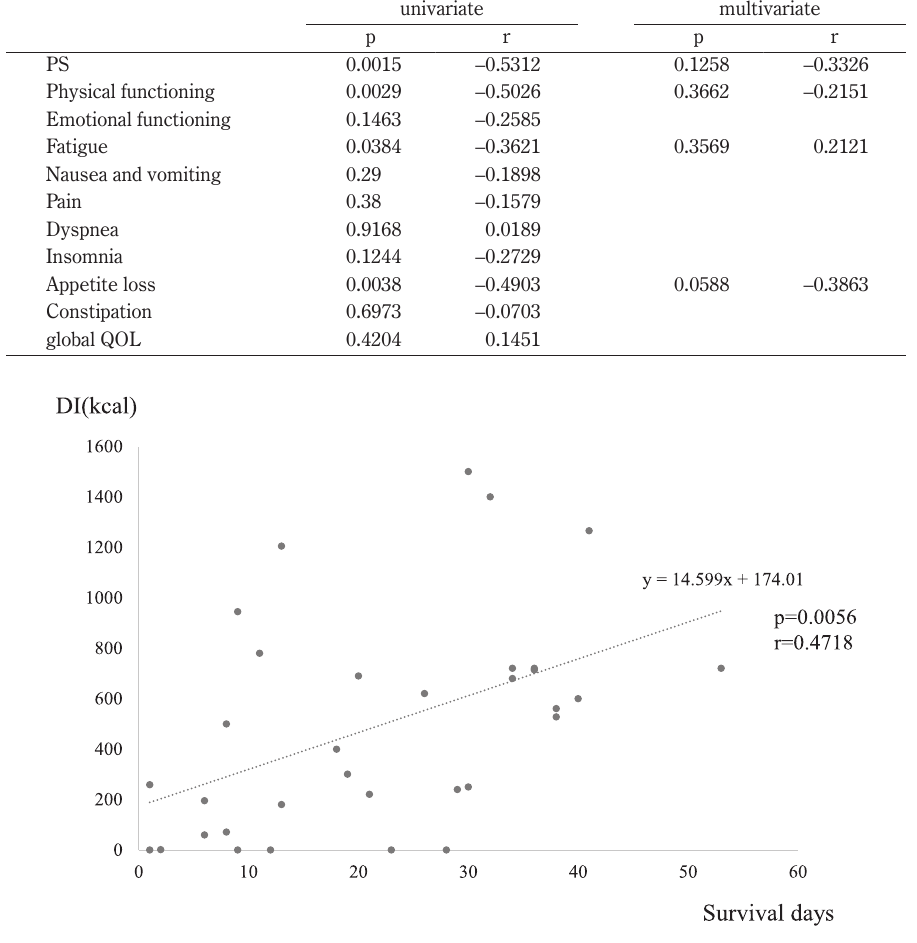
Table 3 Univariate and multivariate analysis with correlations between DI